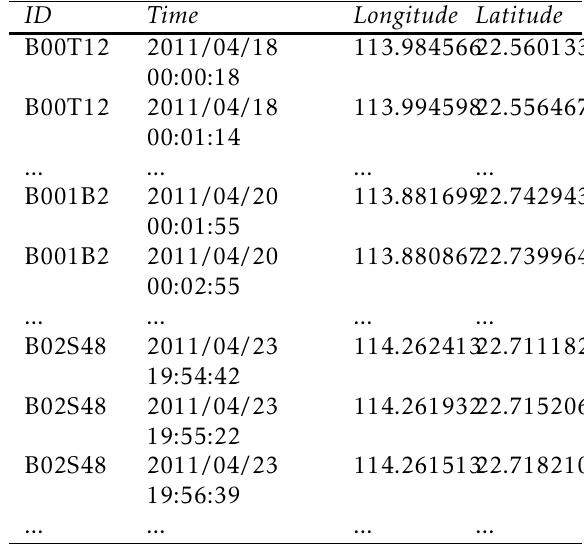
Table 2. Data Sample from Shenzhen’s